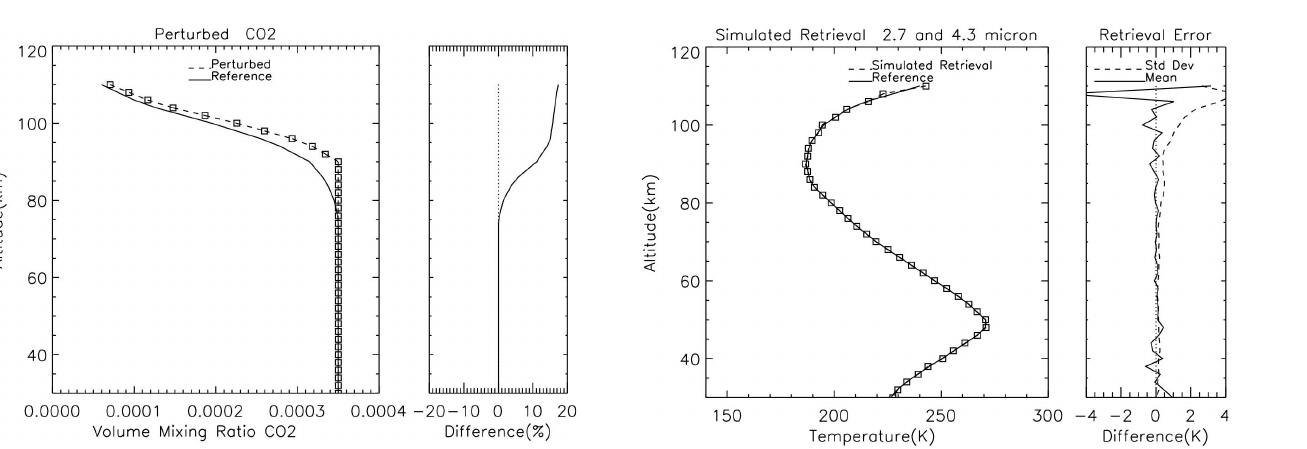
Fig. 19. Temperature results using a two-channel retrieval to over- come lower boundary error of 2% in pressure and 5K in temper- ature. Right-hand panel shows the mean error and error standard deviation due to 10 − 5 random measurement error on broadband av- eraged transmittance.